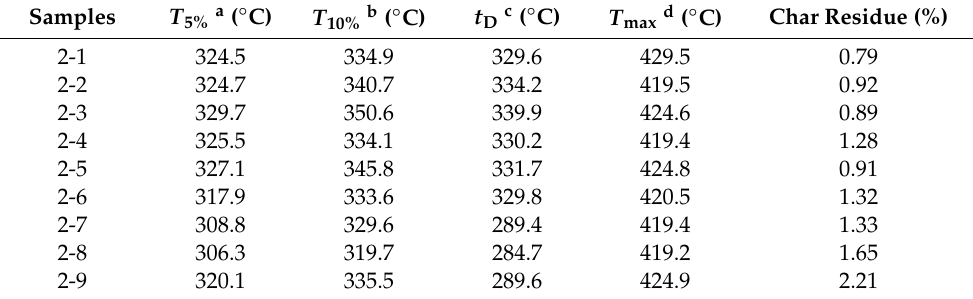
Table 8. Degradation temperature and char residue of polyether-based